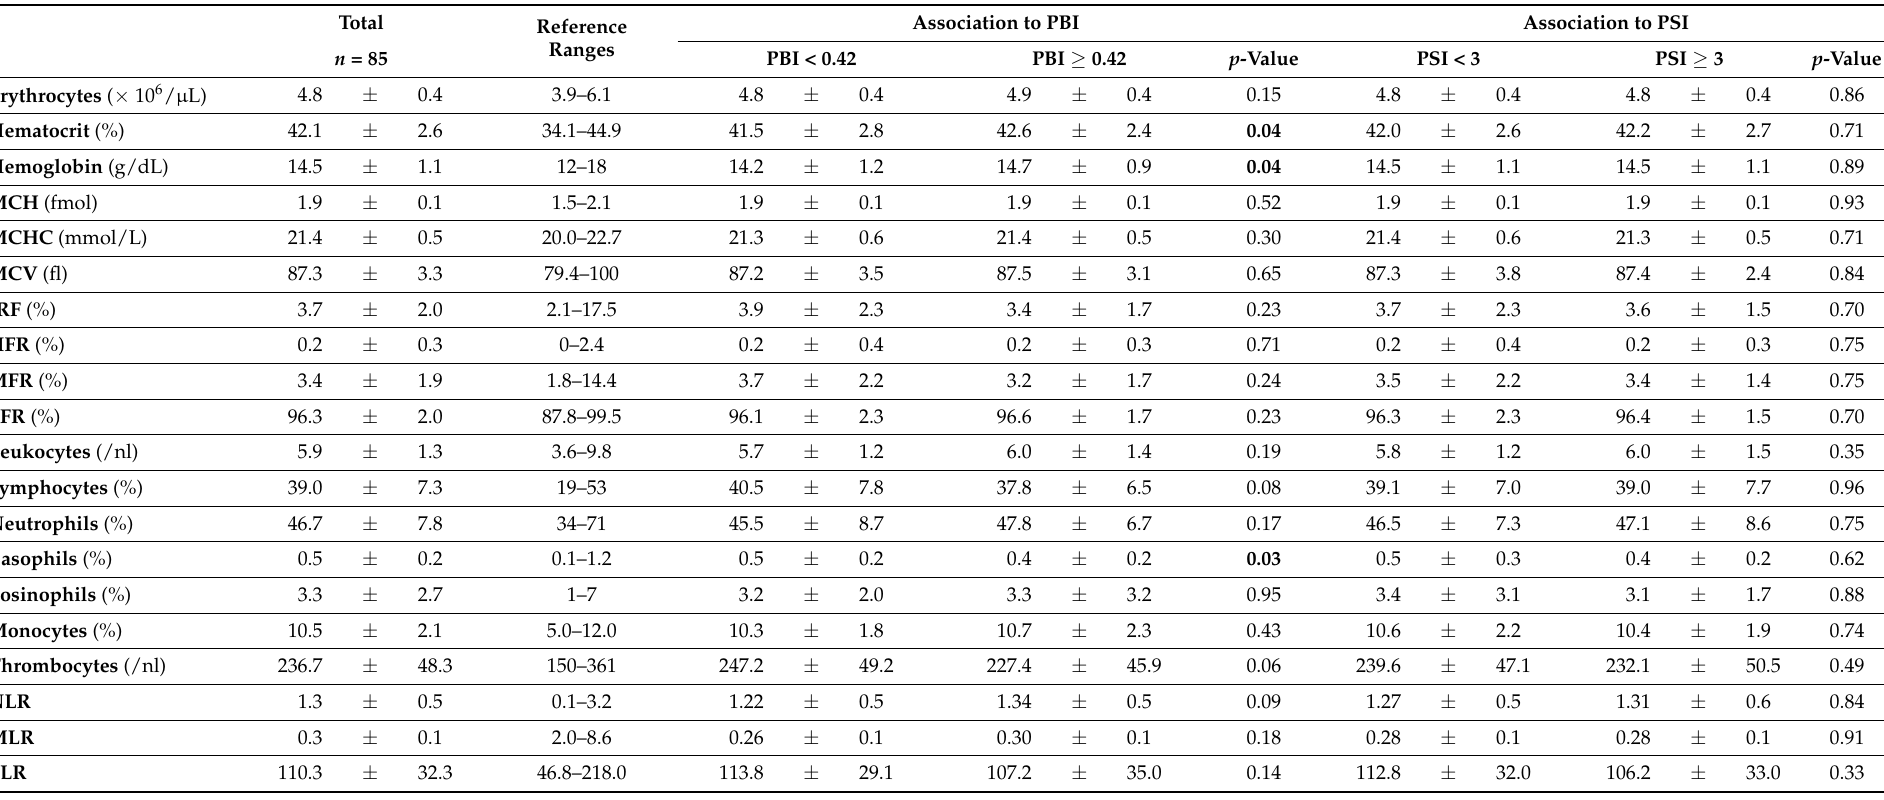
Table 3. Complete blood count (BC) of the athletes (entire cohort) and their associations with periodontal health (PBI and